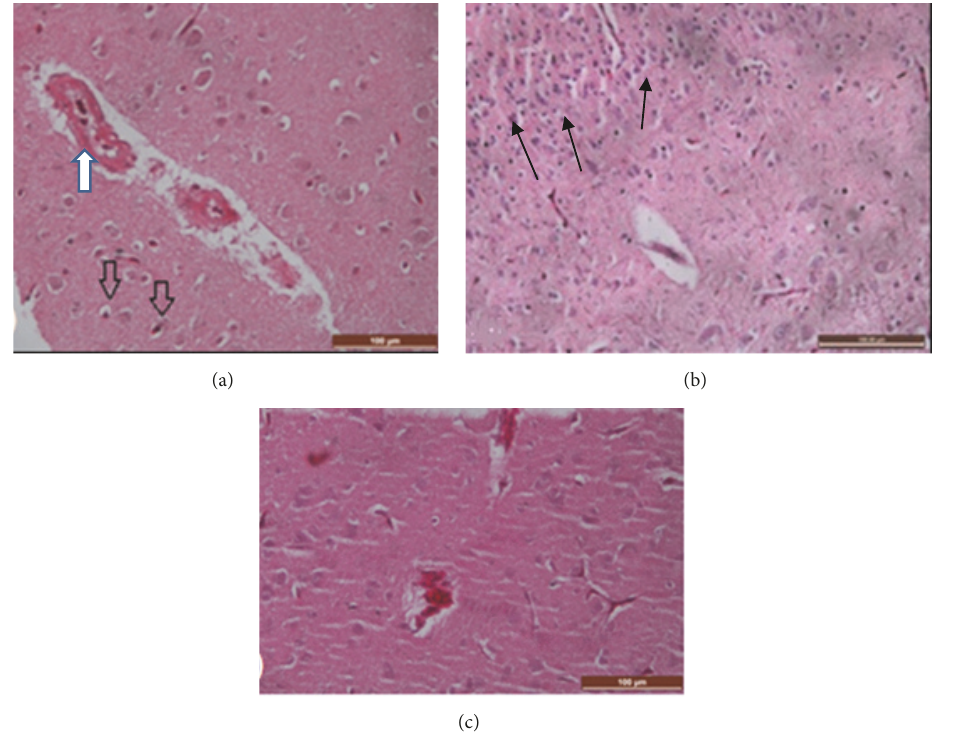
Figure 2: Brain of SPF chickens. (a) Day 5 pi of vNDV, endothelial hypertrophy (white arrow) and neuronal necrosis (black arrow). (b) Day 4 pi of vNDV, gliosis (arrow). (c) Control group, lesion scoring of 0. HE, scale bar = 100 𝜇 m. Table 1: Lesions scoring (0-5) induced by vNDV in HE stained trachea, bursa of Fabricius, and spleen tissues on days 3, 6, and 7 pi. Trachea Bursa of Fabricius Spleen Day 3 pi